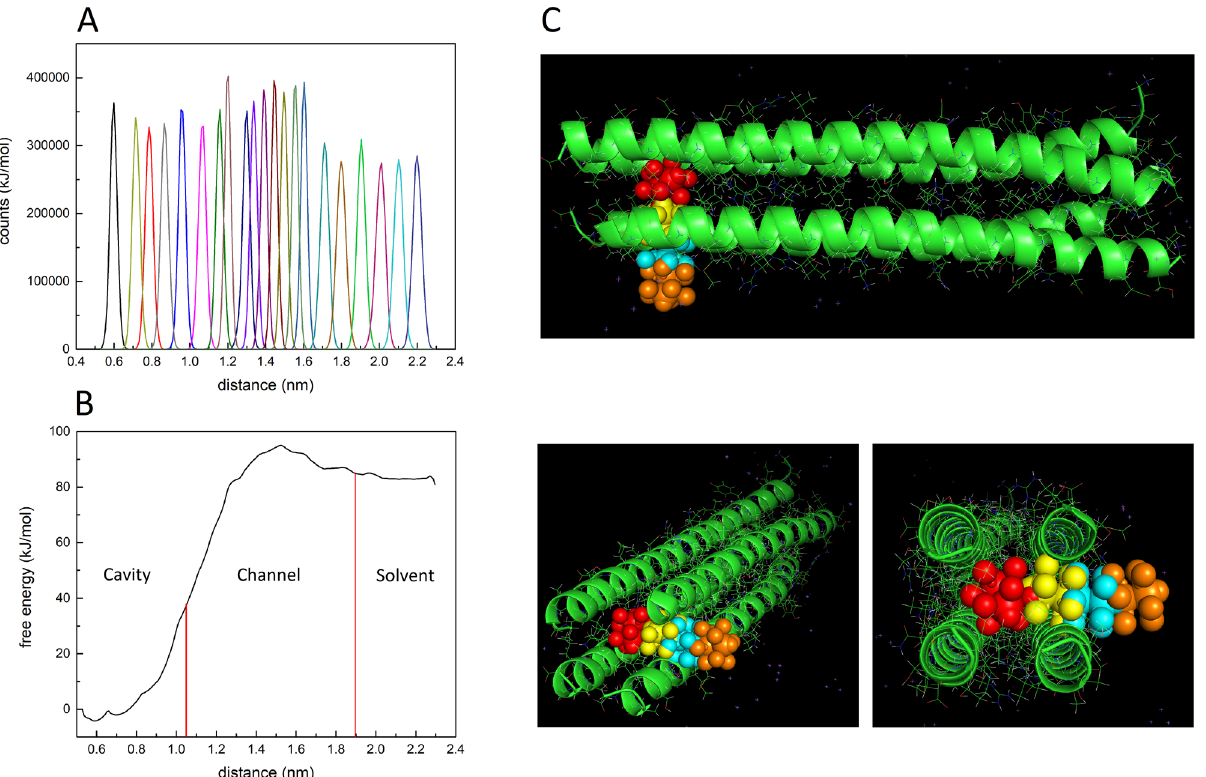
Figure 2. Molecular dynamics simulations of the exit pathway of o -carborane, C 2 B 10 H 12 out of the b d ) of the simulation and ( B ) global free energy, C-terminal cavity of RHCC-NT. ( A ) Biased distribution, P i ( G ( d ) as o -carborane moves out of the cavity through the interhelical channel into the solvent. ( C ) Cartoon representation of calculated o -carborane positions as it moves between the solvent and cavity through